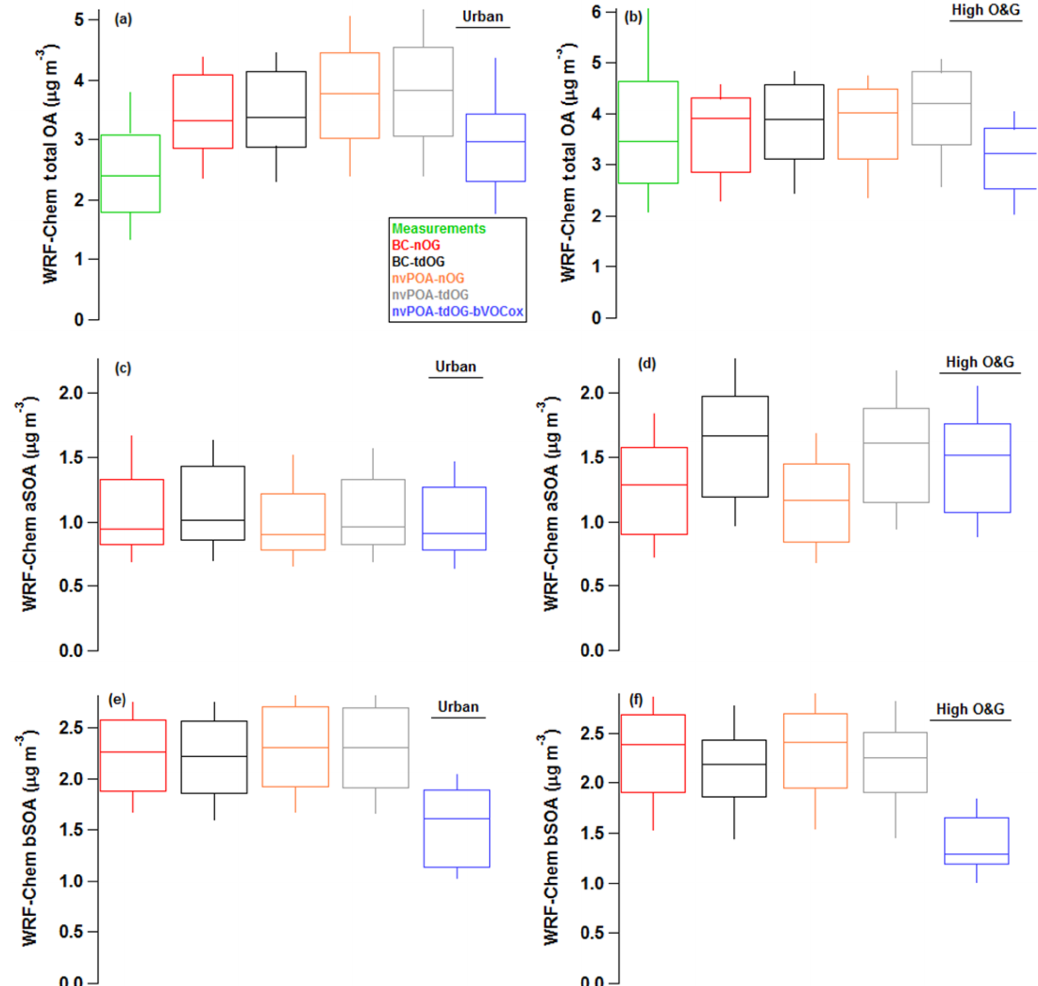
Figure 10. Statistical comparisons of predicted OA, anthropogenic SOA (aSOA), and biogenic SOA (bSOA) in urban-influenced (a, c, e) and high-O&G-influenced (b, d, e) plumes in different model scenarios. Data from measured OA are also included in (a–b) . Box and whisker plots depict the 10th, 25th, 50th, 75th, and 90th